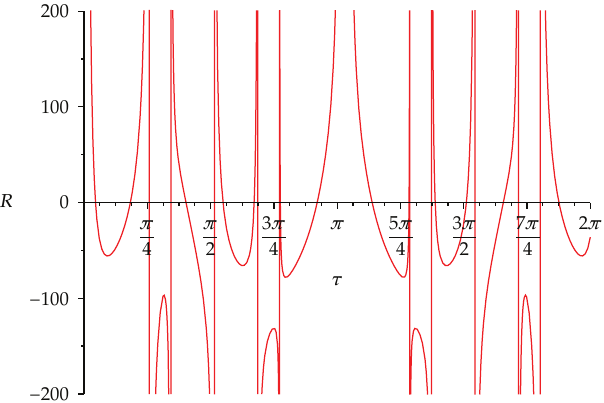
Figure 10: The evolution of the R with respect of the cosmic time τ for (cid:2) 3.18 (cid:3)